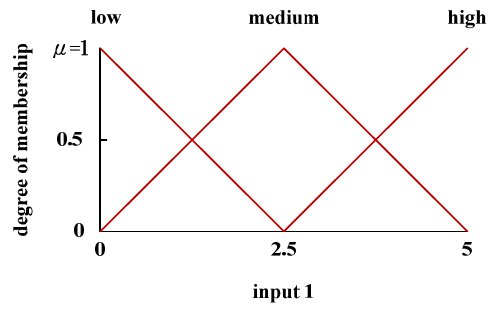
Figure 2. Degree of membership of the cutting speed.